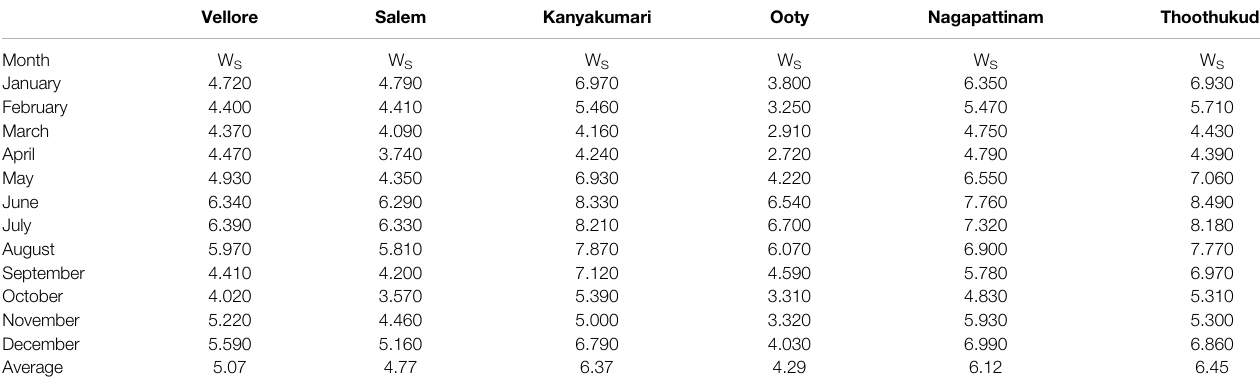
TABLE 4 | Pro fi le of wind speed at various zone descriptions at Tamil Nadu. Vellore